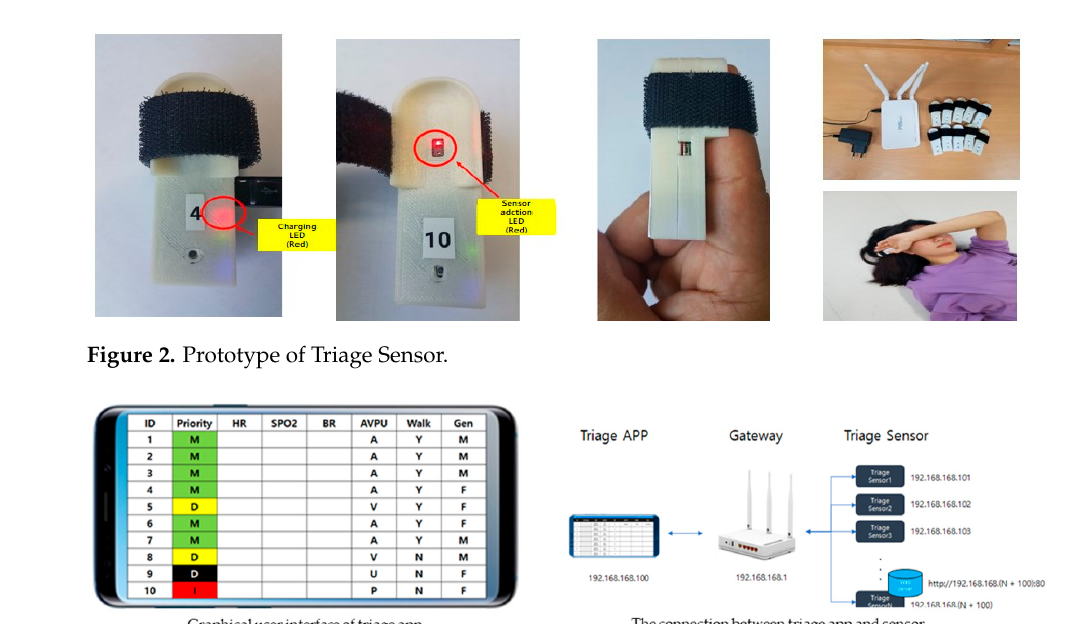
Figure 3. User Graphic Interface of Triage